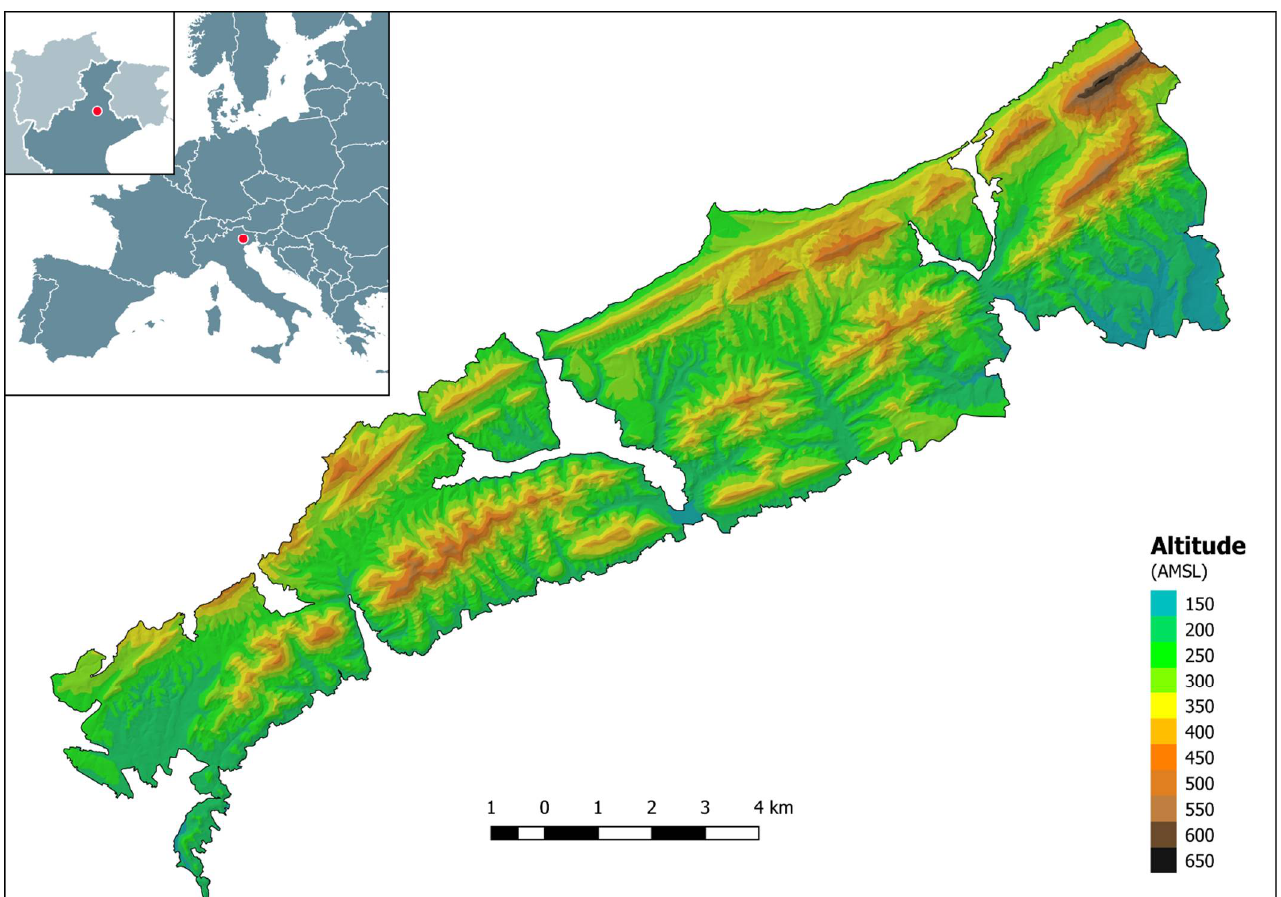
Figure 1. The study area, corresponding to the Core Area of the UNESCO site Le Colline del Prosecco di Conegliano e Valdobbiadene, is located in the Veneto Region in northeastern Italy.